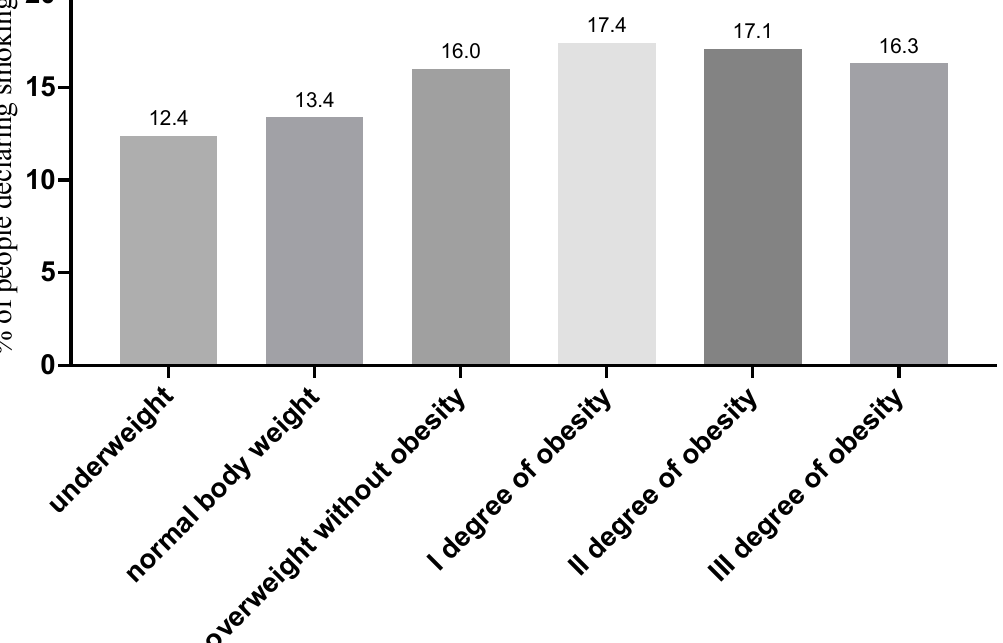
Figure 3. Percentage of people declaring smoking depending on the BMI category (due to the number of groups compared, results for differences are not shown in the figure).